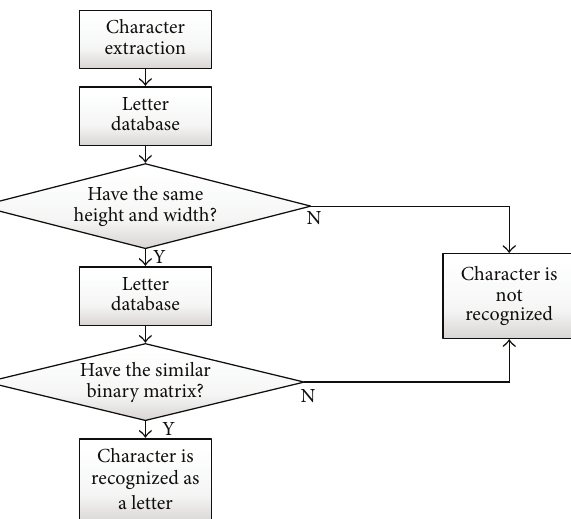
Figure 8: The flowchart of the character recognition.